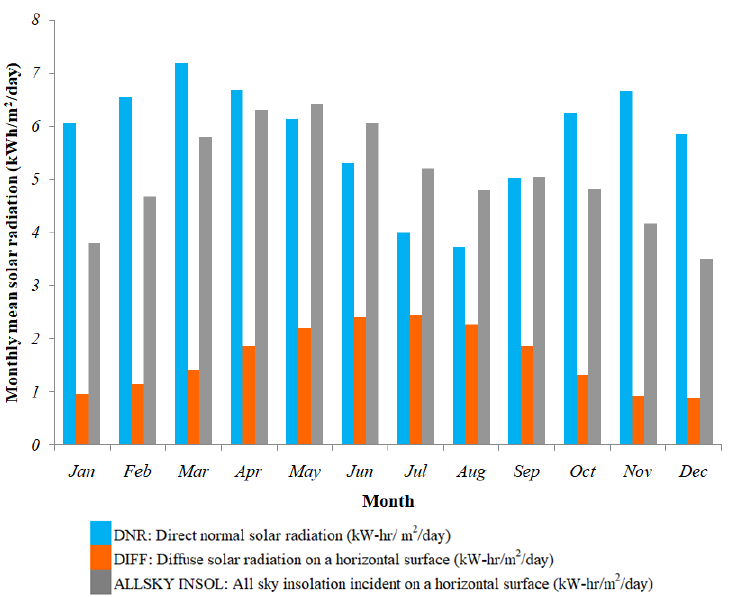
Figure 3. Comparison of ALLSKY INSOL, DIFF and DNR of the sun’s radiation of the selected region.